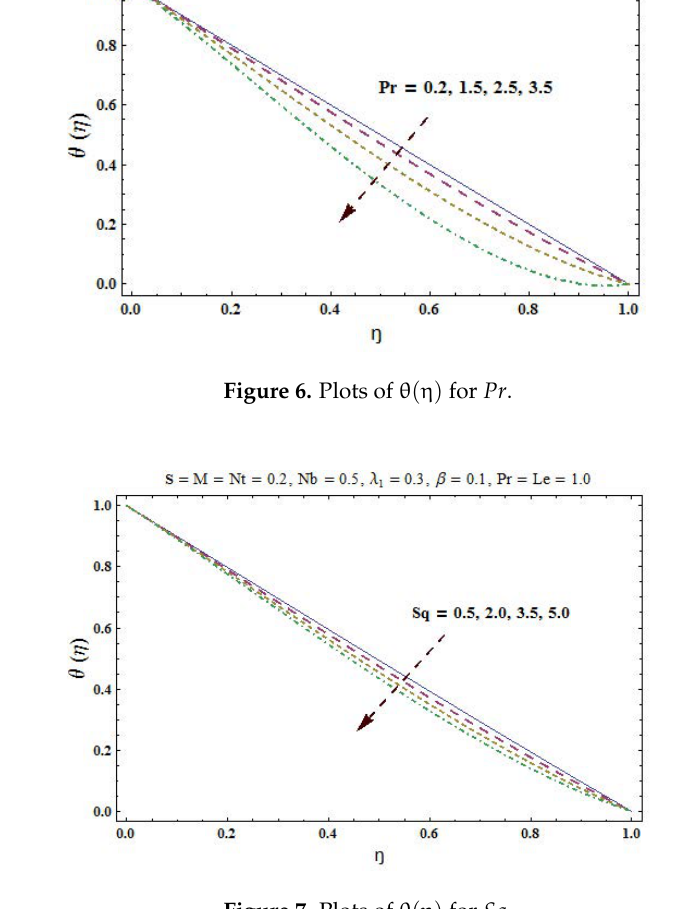
Figure 7. Plots of θ ( η ) for Sq .